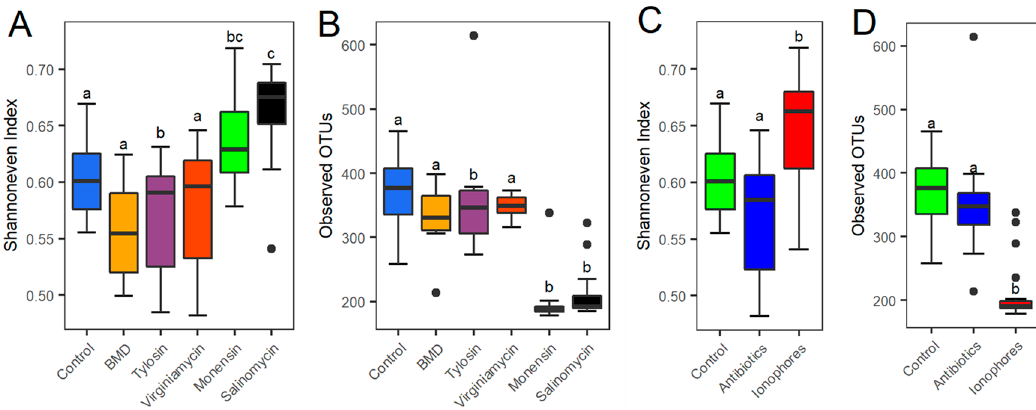
Figure 1. The α -diversity of cecal microbiota of broilers following 2-week supplementation of different antimicrobials. Changes in evenness and richness were calculated from 12 samples of each treatment using the Shannon evenness index ( A ) and observed operational taxonomic units (OTUs) ( B ), respectively. Data from three antibiotics and two ionophore groups were further combined separately and the Shannon evenness index ( C ) and observed OTUs ( D ) were recalculated. Results were plotted using box and whisker plots, in which the middle line denoted the median value and the lower and upper hinges represented the first and third quartiles, respectively. Whiskers extended from the hinge to the highest or lowest value no farther than 1.5 × the inter-quartile range. Points outside of this range are considered outliers. One-way ANOVA with post hoc Tukey’s test was performed, with the treatments not sharing a common superscript considered significantly different ( p < 0.05).